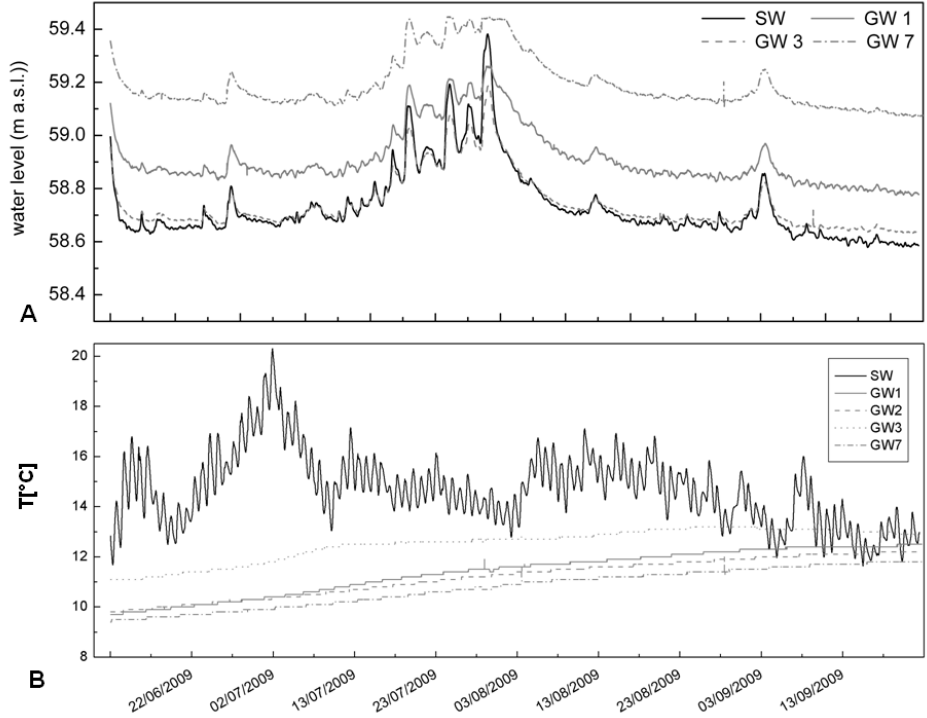
Fig. 5. (A) : surface water levels (SW3, Fig. 1B) and groundwater heads measured at representative locations shown in Fig. 1 for the period of 1 June 2009–30 September 2009. (B) : surface water and groundwater temperatures at the locations shown in Fig. 1 for the period of 1 June 2009–30 September